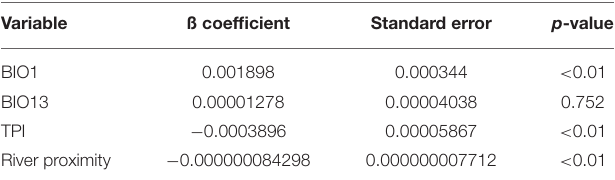
TABLE 2 | Regression logistic results using variables BIO 1, BiO 13, TPI, and river